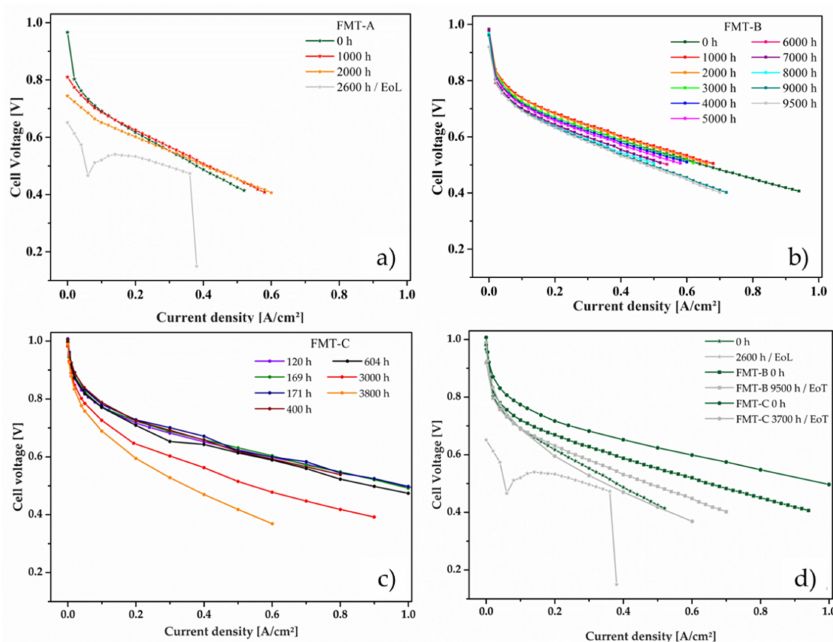
Figure 2. Polarization curves under dry reformate and air supply ( λ = 1.3 / 2.0), recorded at begin of life BoL, end of test / end of life EoT / EoL and at certain intervals: ( a ) FMT-A, ( b ) FMT-B, ( c ) FMT-C, and ( d ) comparison of FMT-A, FMT-B, and FMT-C at BoL / EoL /